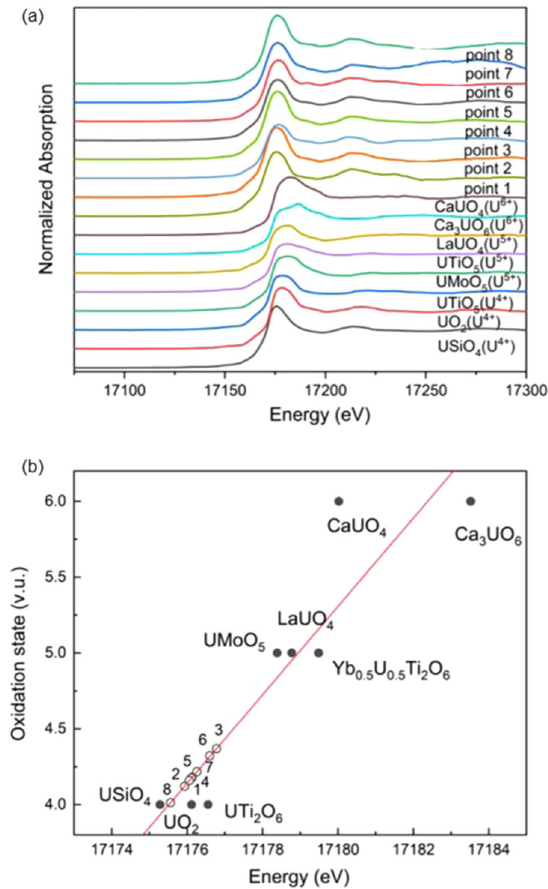
Fig. 7 µ-focus U L 3 edge X-ray Absorption Near Edge Spectro- scopy ( μ -XANES) spectra of simulant MCCI-1 and MCCI-2. Showing a XANES spectra of U reference compounds and representative crystalline phases; and b average U oxidation states of points located on the sample (open circles), compared with a range of U reference compounds of known oxidation state ( fi lled circles, labelled) as a function of X-ray